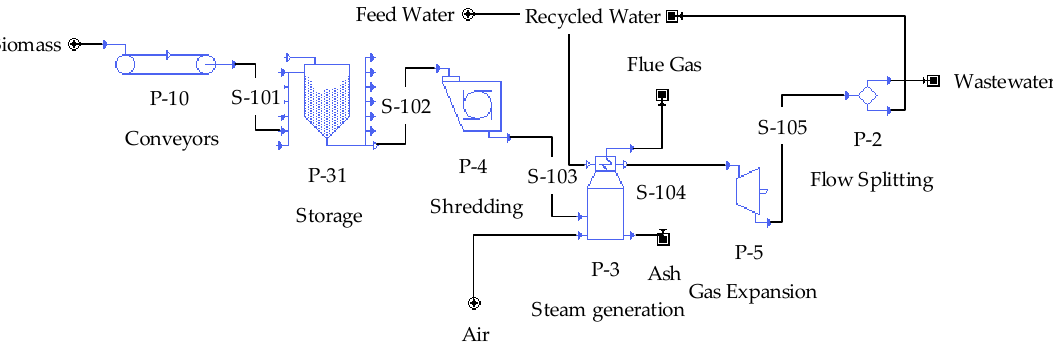
Figure 1. Schematics of the flowsheet developed in SuperPro Designer.